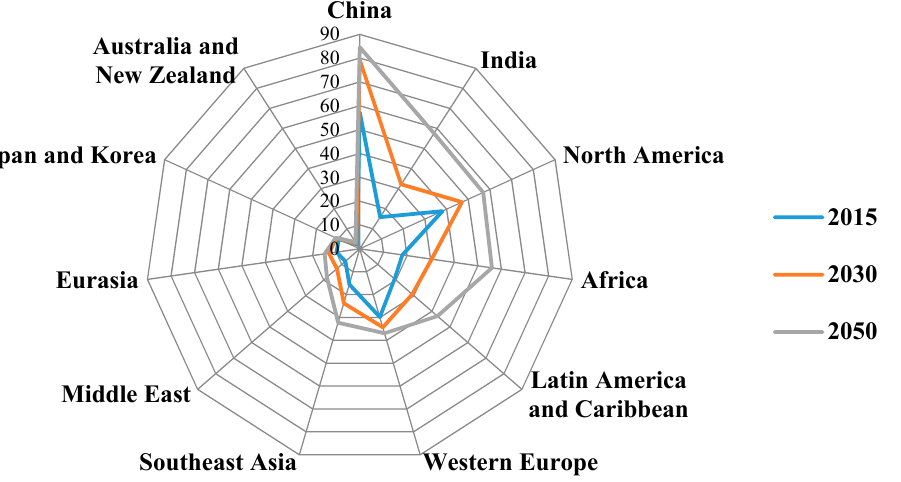
Figure 1. Building Floor Area growth by Region in Billion m 2 . Source: (Towards Low-GHG and Resilient Buildings 2016) .